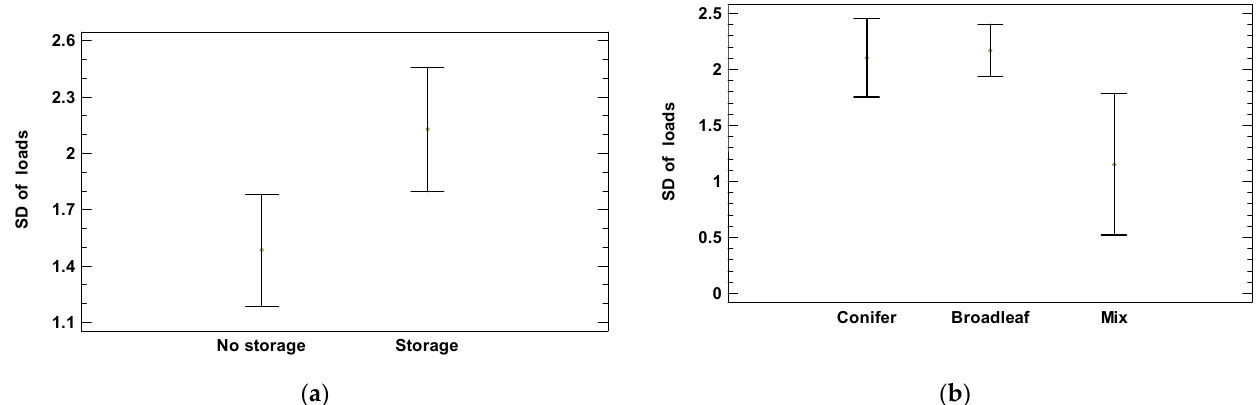
Figure 6. Means plot of the influence of storage ( a ) and species ( b ) factors over SD t values.